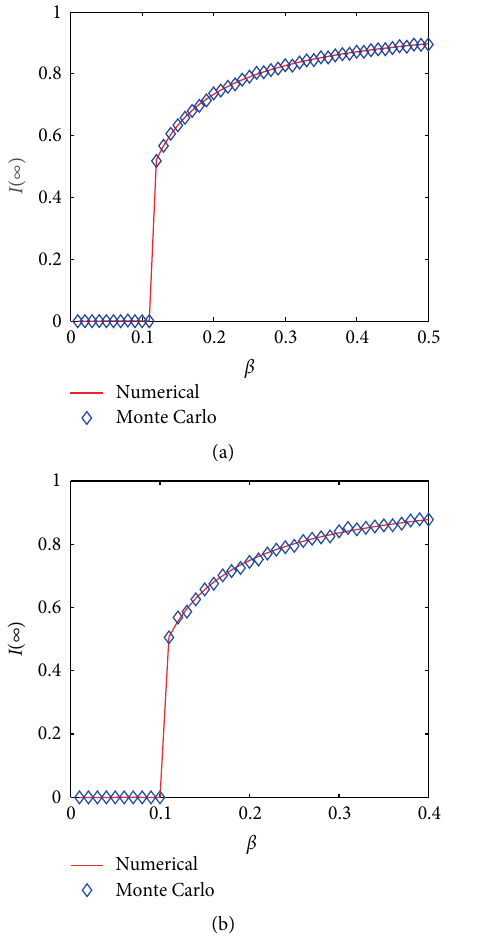
Figure 3: The outbreak scale as a function of the infection on the (a) random network with , (b) AD network rate −2 . The solid and with 𝐼(∞) dotted lines represent numerical simulations and Monte Carlo 𝛽 ⟨𝑘⟩ = 6 𝐹(𝑎) ∝ 𝑎 , 𝑎 ∈ {0.5, 0.6, 0.7, 0.8, 0.9} simulations, respectively. Other parameters are . Figure 4: The outbreak scale as a function of propaga- 𝛿 = 0.06, , and on the AD network with tion parameters 𝛾 = 𝜇 = 0.1, ℎ = 3, 𝑁 = 5000, 𝐼(0) = 0.01, 𝑆(0) = 0.99 𝐼(∞) 𝛽, 𝛿 𝛾 𝐹(𝑎) ∝ 𝑎